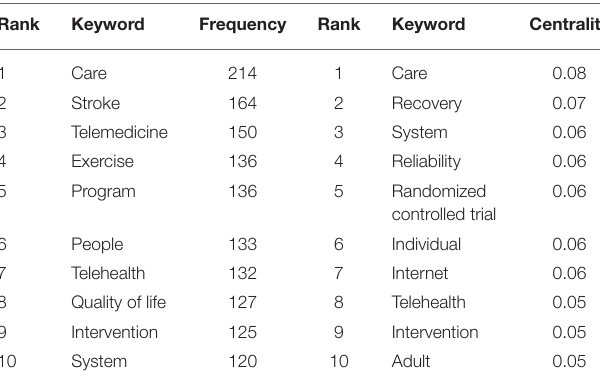
TABLE 6 | Top 10 frequency and centrality of keywords to telerehabilitation.